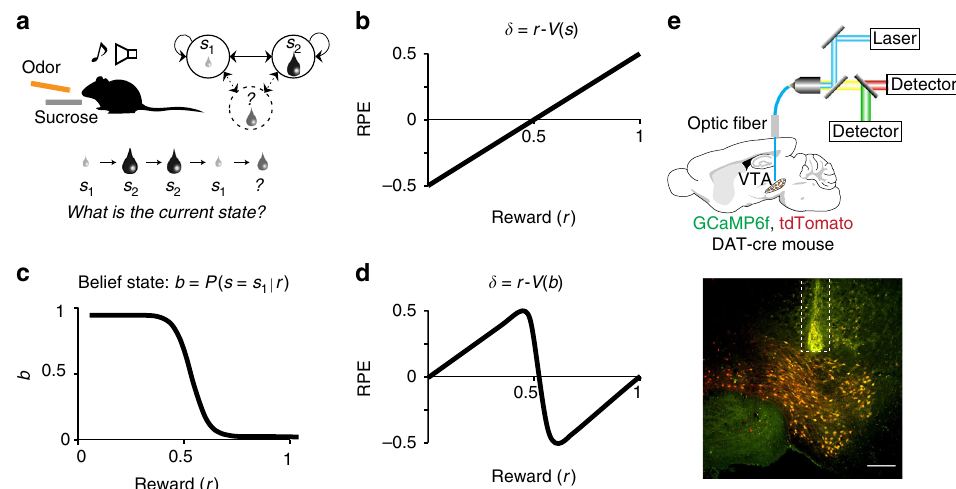
Fig. 1 Task design to test the modulation of dopaminergic RPEs by state inference. a Mice are trained on two perceptually similar states only distinguished by their rewards: small ( s 1 ) or big ( s 2 ). The different trial types, each starting by the onset of a unique odor (conditioned stimulus, CS) predicting the delivery of sucrose (unconditioned stimulus, US), were presented in randomly alternating blocks of fi ve identical trials. A tone indicated block start. Only one odor and one sound cue were used for all blocks, making the two states perceptually similar prior to reward delivery. To test for state inference in fl uence on dopaminergic neuron signaling, we then introduced rare blocks with intermediate-sized rewards. Using (with reinforcement learning (RL) operating on belief states) or not (with standard RL) the training blocks as reference state for computing the value of the novel intermediate states predicts contrasting RPE patterns ( b vs d ). b RPE across varying rewards computed using standard RL. Because the same odor preceded both reward sizes, a standard RL model with a single state would produce RPEs that increase linearly with reward magnitude. c Belief state b across varying rewards de fi ned as the probability of being in s 1 given the received reward. d RPE across varying rewards computed using the value of the belief state b . A non-monotonic pattern across increasing rewards is predicted when computing the prediction error on the belief state b . e (Top) Population activity of VTA dopaminergic neurons is recorded in behaving mice using fi ber photometry. (Bottom) Fiber location above the recorded cells in the VTA, which co-express the calcium reporter GCaMP6f and the fl uorescent protein tdTomato (scale bar: 200 μ